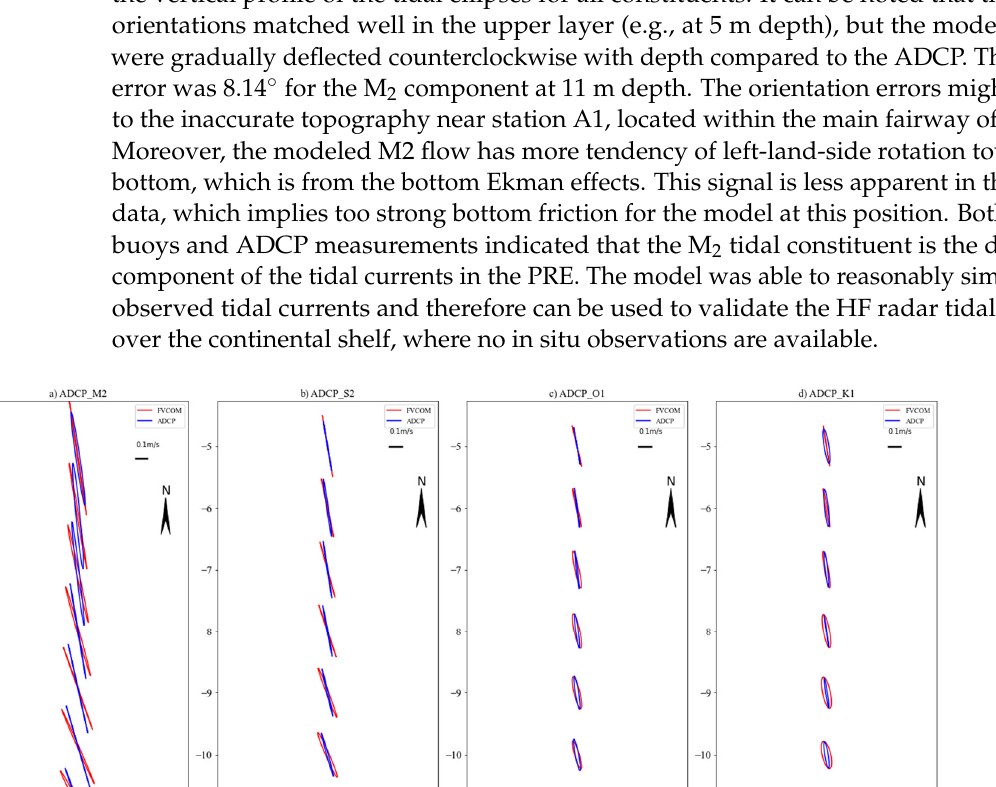
2 , S 2 , K 1 , O 1 ) at station A1: model (red) and ADCP